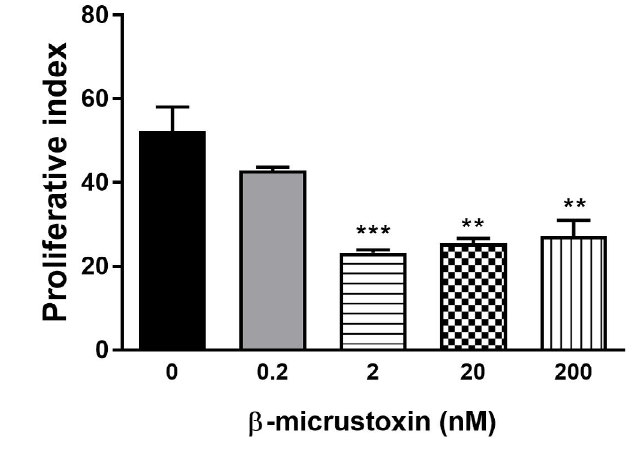
Figure 5. Proliferative index of cultured astrocytes incubated in the absence (control) or presence of β-micrustoxin (0.2, 2, 20, 200 nM) for 24 h evaluated by fluorescence of the carboxyfluorescein diacetate succinimidyl ester (CSFE) and flow cytometry. One-way ANOVA: p < 0.01; Bonferroni post-hoc test: **p < 0.01; ***p < 0.001 vs. control. N =